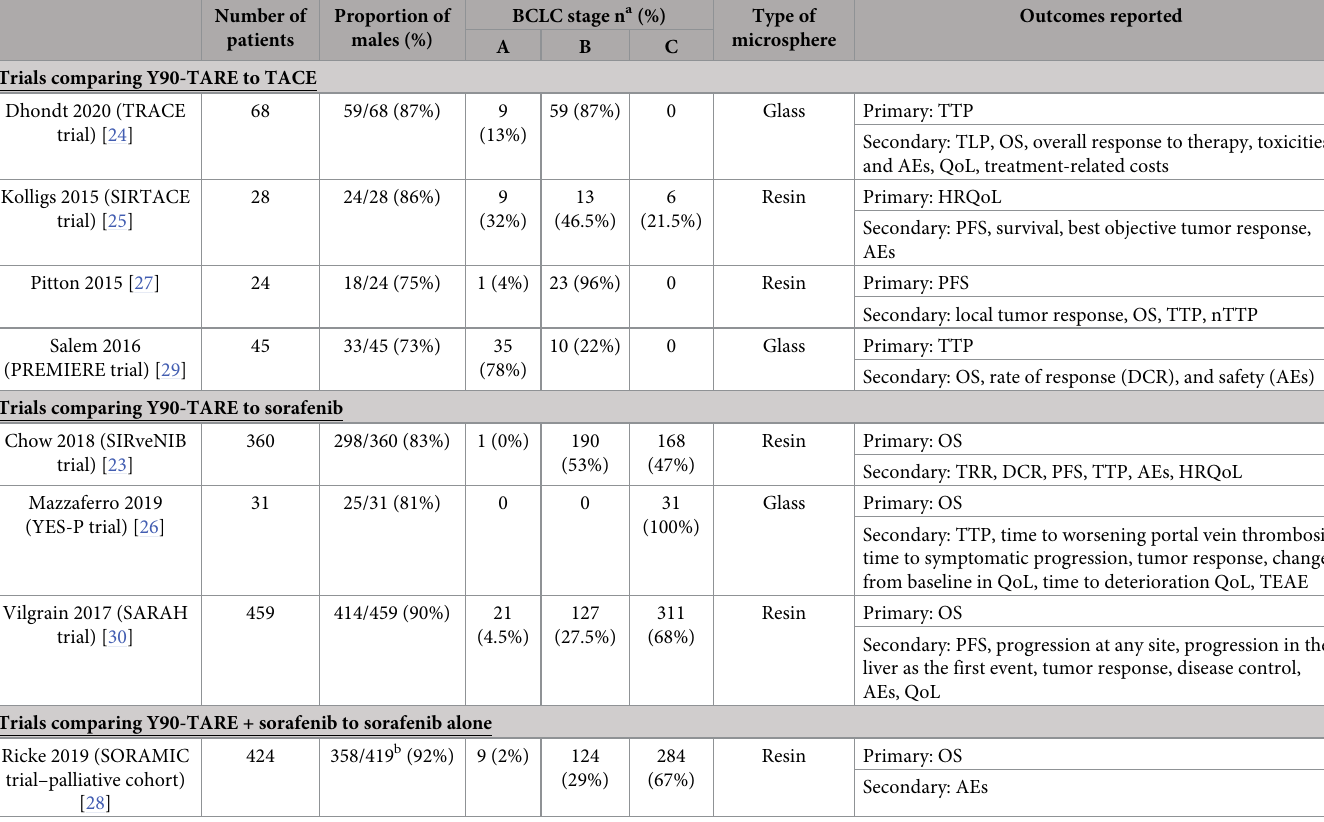
Table 1. Characteristics of included